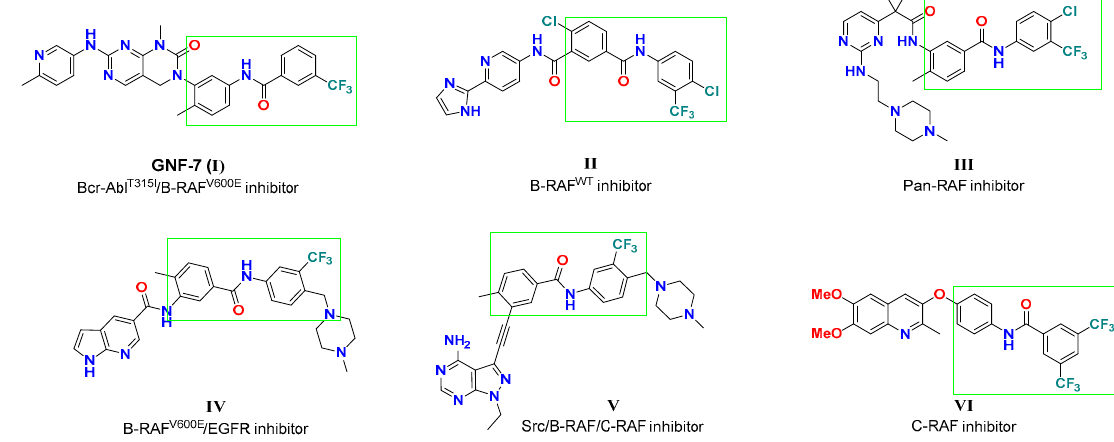
Figure 2. Representative examples of various diarylamides as RAF kinase inhibitors.